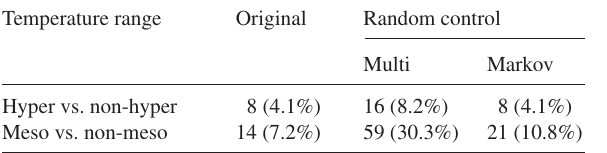
Table 3. Number of leave-one-out mispredictions when classifying an organism into two temperature optimum ranges, hyperthermophile versus non-hyperthermophile (hyper vs. non-hyper) and mesophile versus non-mesophile (meso vs. non-meso) using all tetramers fre- quencies over the entire vitrual coding strand, based on a model from the genomes of the other 194 organisms. The leave-one out classifica- tionswere made for the 195 originalgenomes (original)and two types of randomly generated control sequences, multinomial (multi) and Markov.